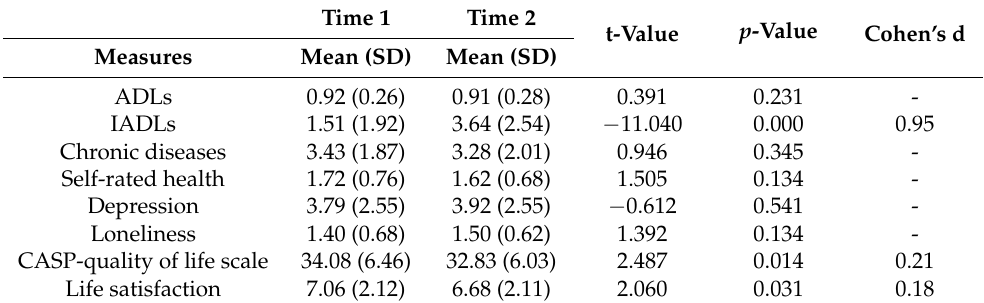
Table 1. Mean difference in perceived health, mental health, and subjective well-being between Time 1 and Time